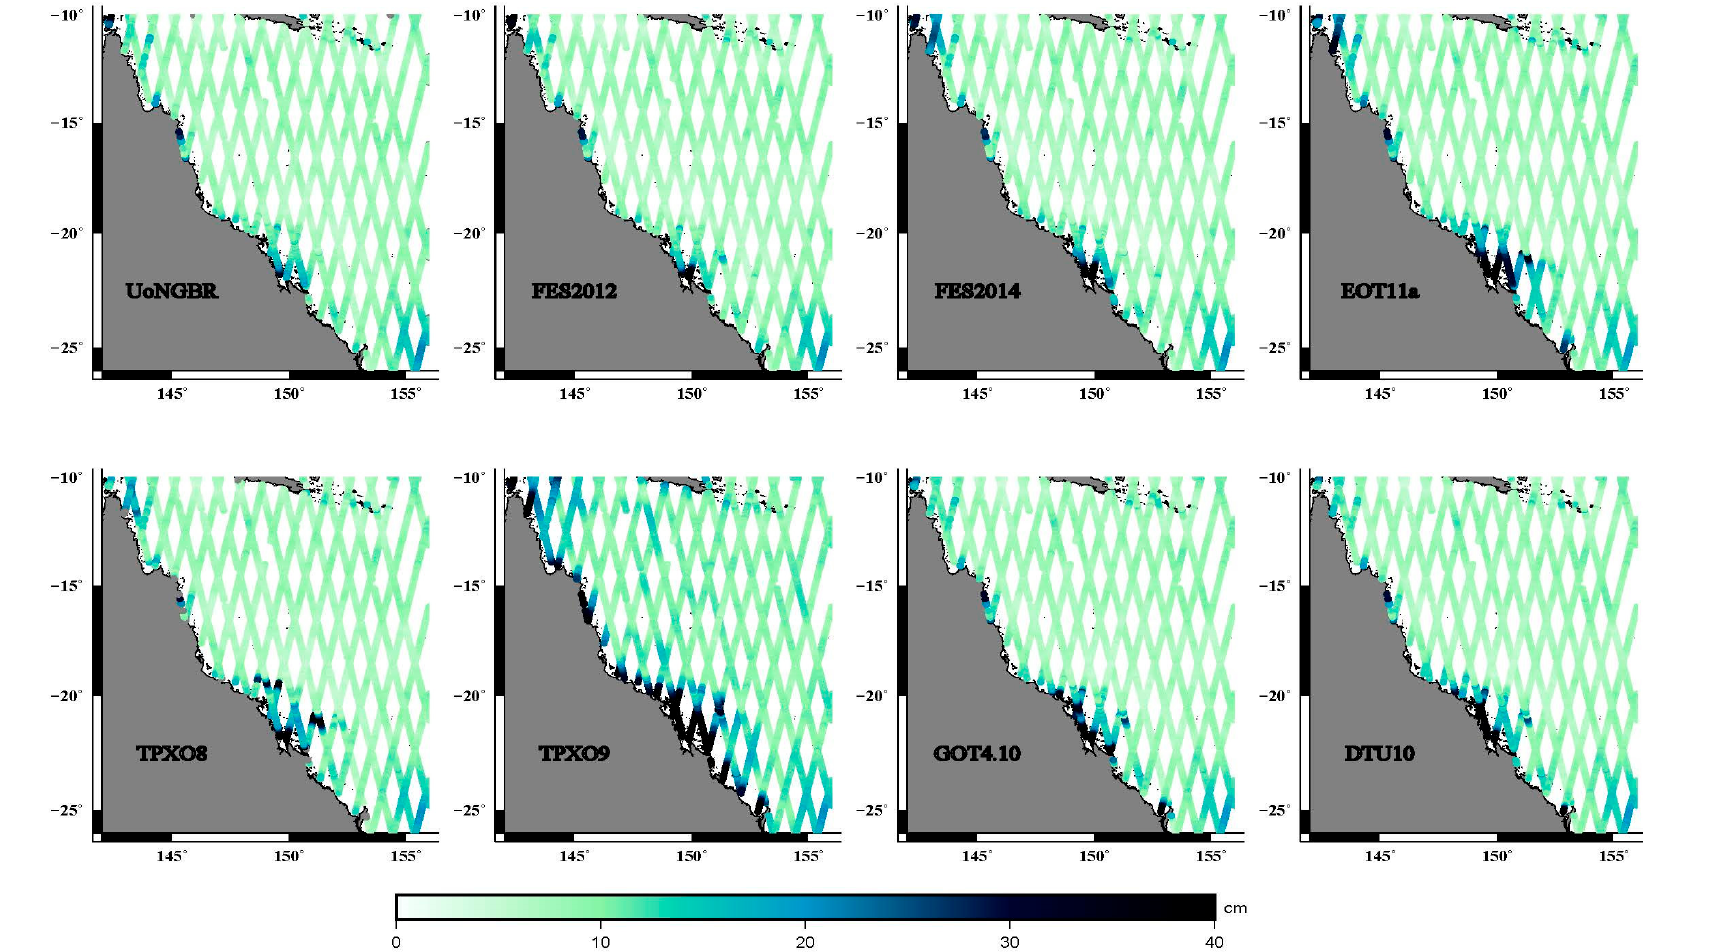
Figure 7. The pointwise RMS values shown along Sentinel-3A tracks.